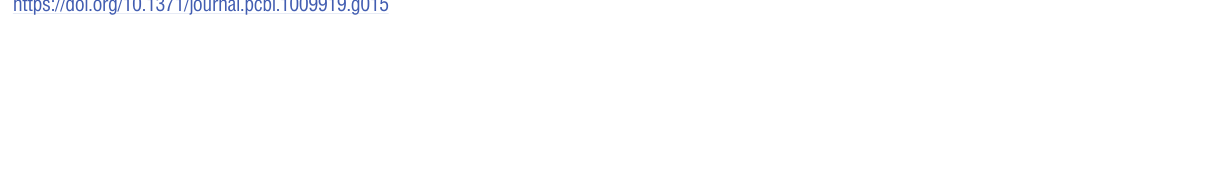
PLOS Computational Biology | https://doi.org/10.1371/journal.pcbi.1009919 March 9,